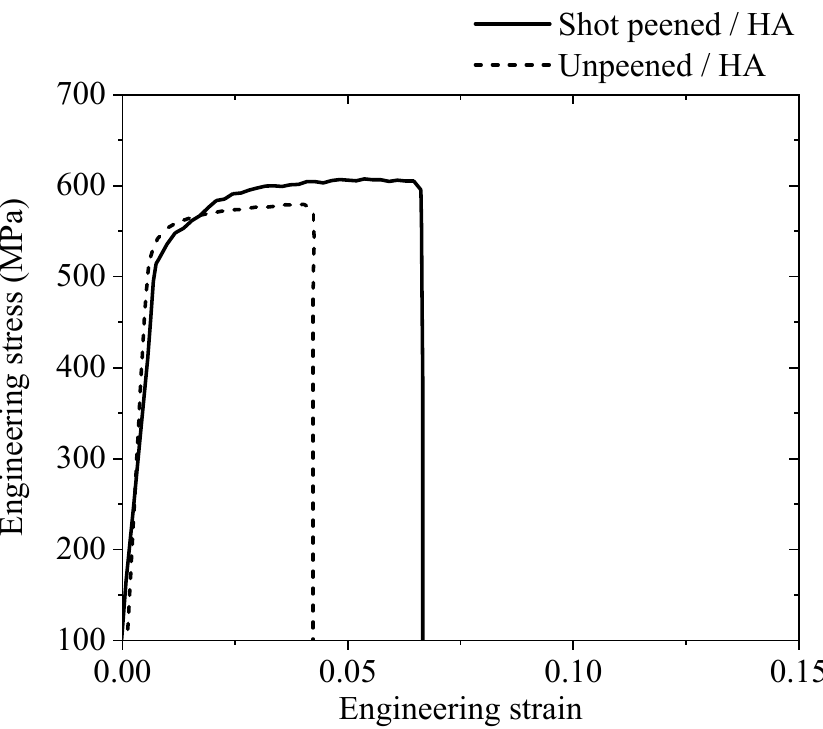
Figure 2. ( a ) Tensile test specimen cut from the 7075 aluminum alloy, ( b ) representative tensile stress–strain curves of the specimens which were tested in dry nitrogen gas (DNG) at strain rate of 10 − 5 min − 1 .